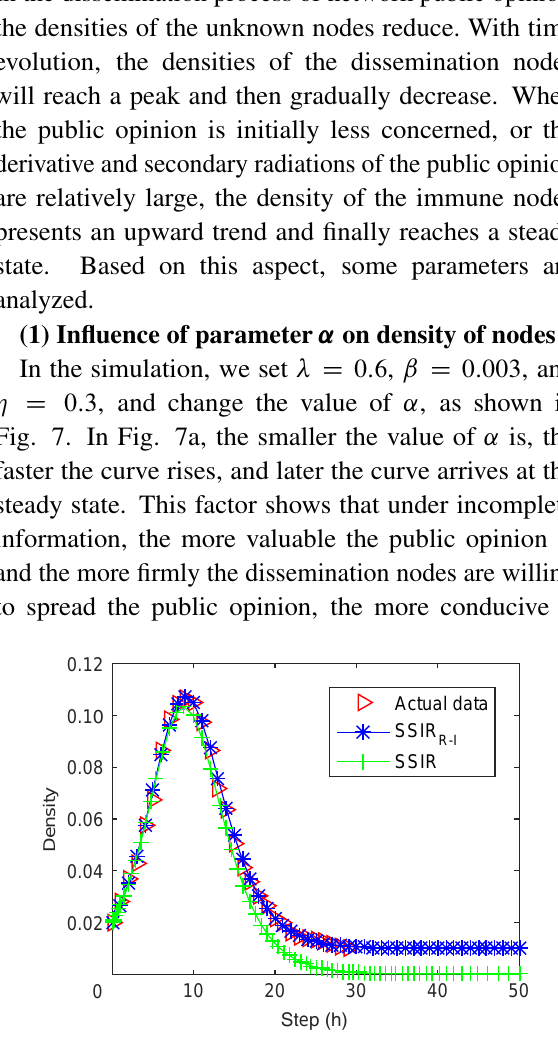
Fig. 6 Density comparison between actual and simulation data.